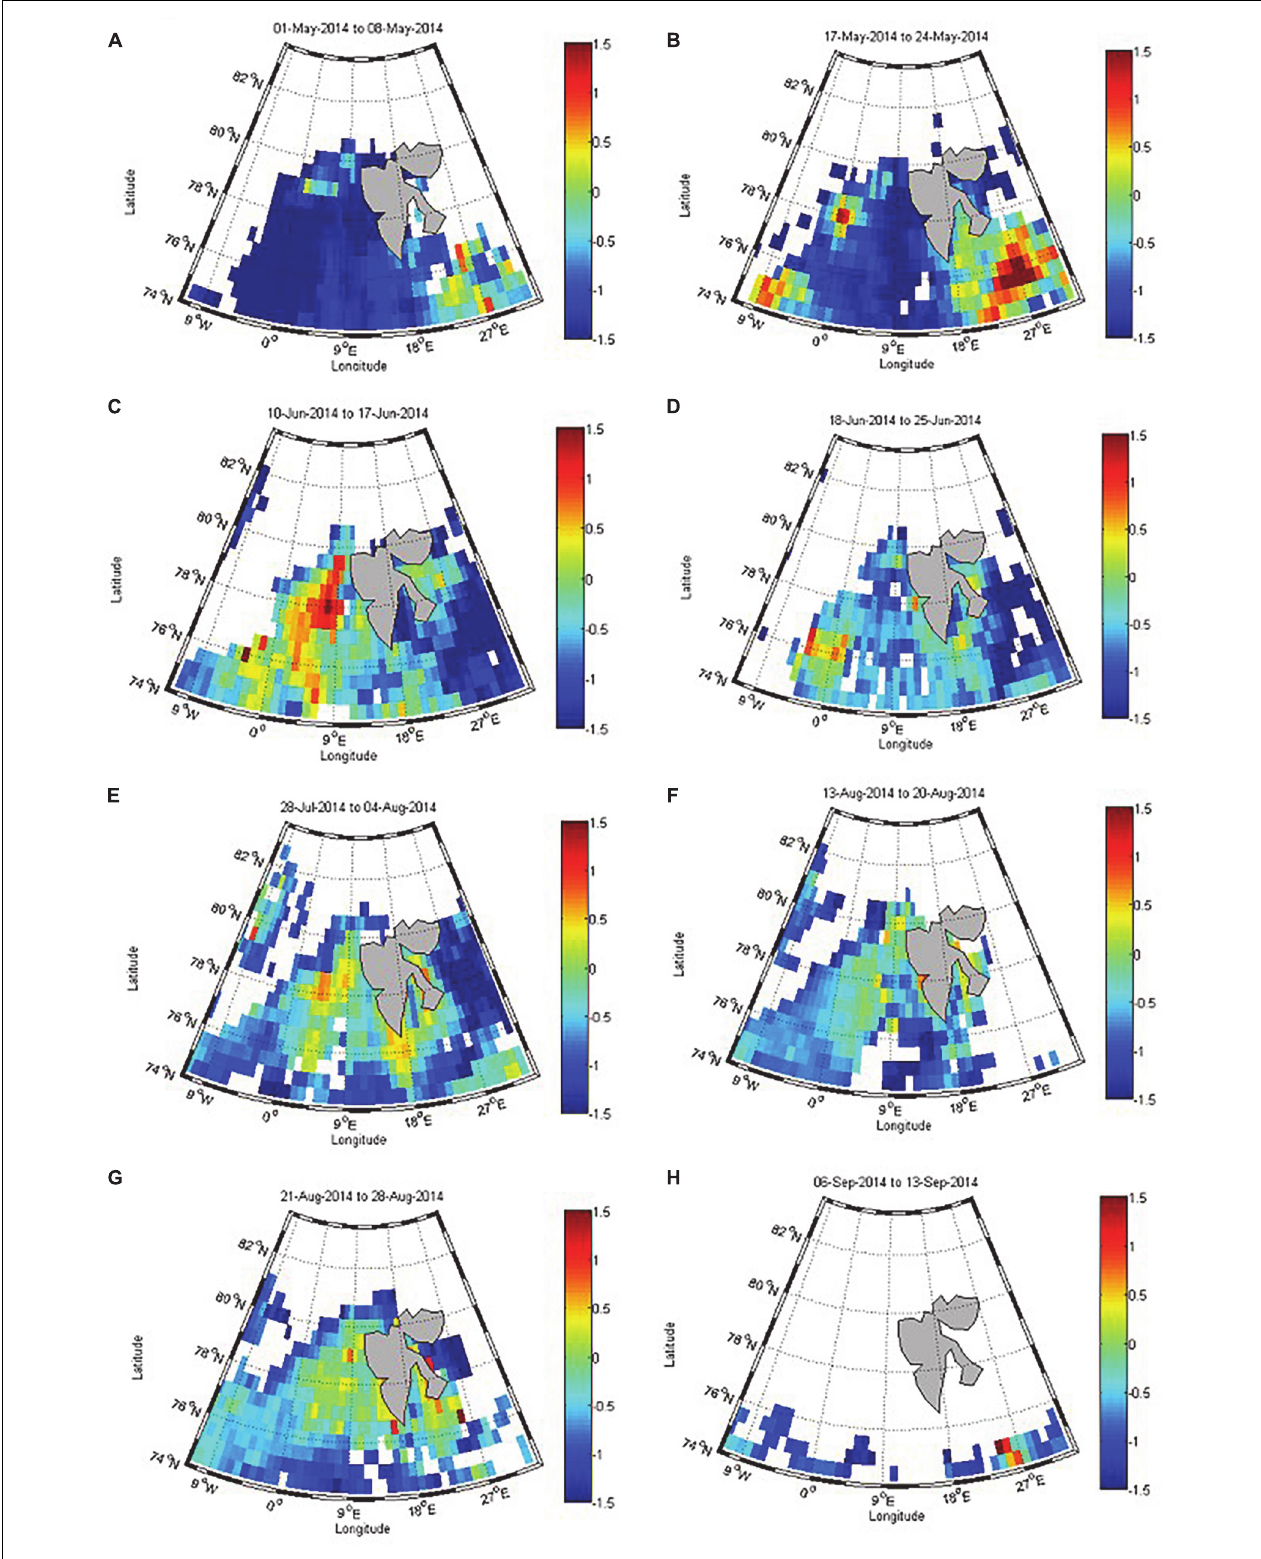
FIGURE 7 | Remotely sensed chlorophyll a (Chl sat , 8-day average) in May (A,B) , June (C,D) , July (E) , August (F,G) , and September (H) , in 2014. Red values show the highest concentration and blue the lowest values on a logarithmic scale in mg m − 3 .